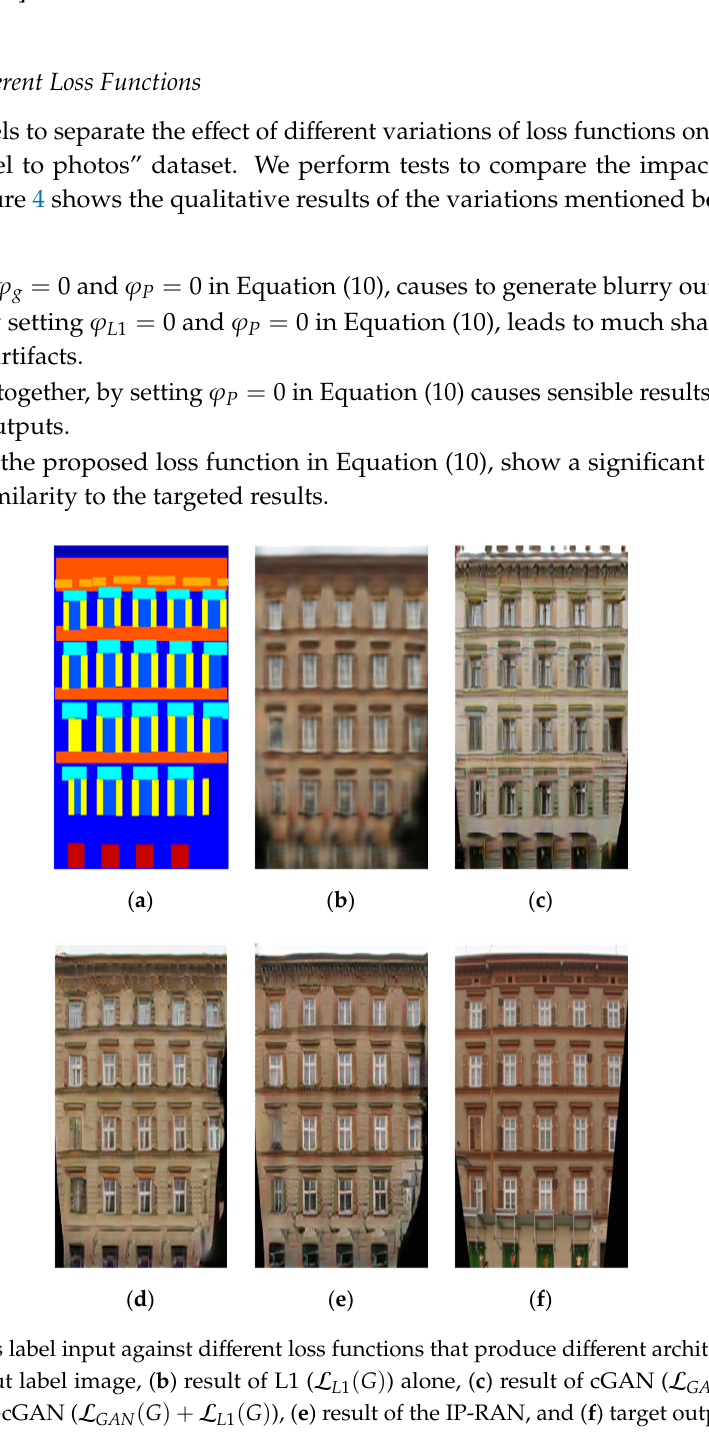
results. ( a ) input label image, ( b ) result of L1 ( L L 1 ( G ) ) alone, ( c ) result of cGAN ( L GAN ( G ) ) alone, ( d ) result of L1 + cGAN ( L GAN ( G ) + L L 1 ( G ) ), ( e ) result of the IP-RAN, and ( f ) target output